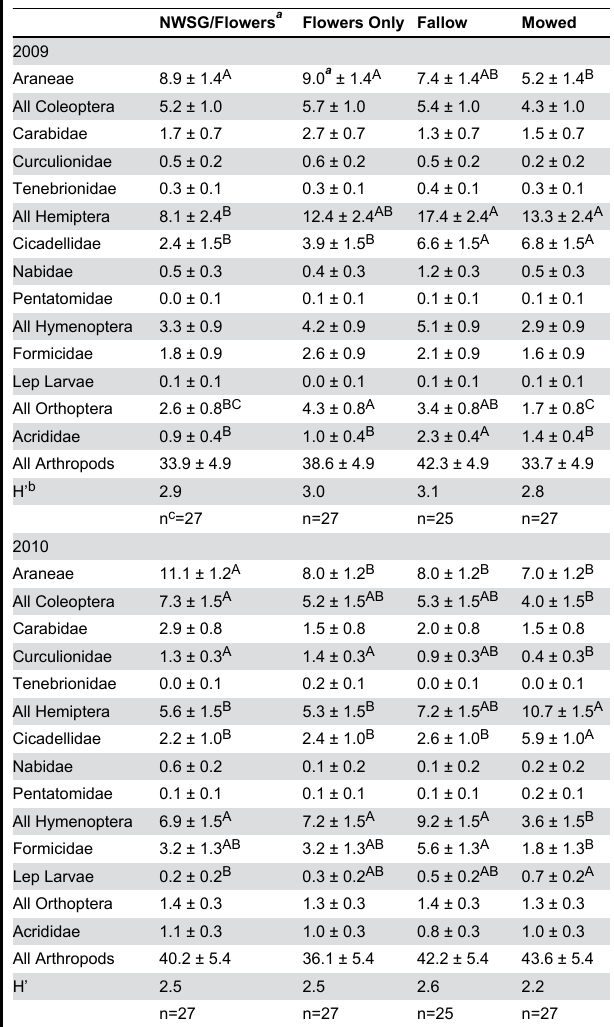
Table 2. Estimated least-square mean ± SE mass (mg) of most important taxonomic orders and families of arthropods consumed per northern bobwhite chick over 30-minute foraging trials in four field border treatments (June to August 2009 and 2010).